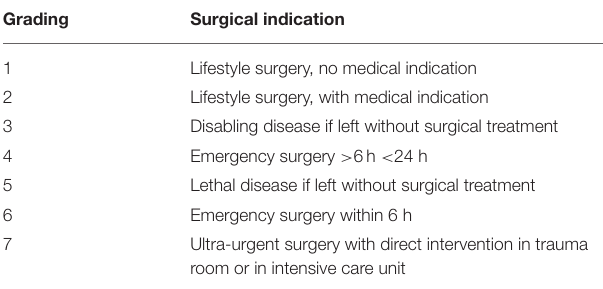
TABLE 2 | Grading of surgical